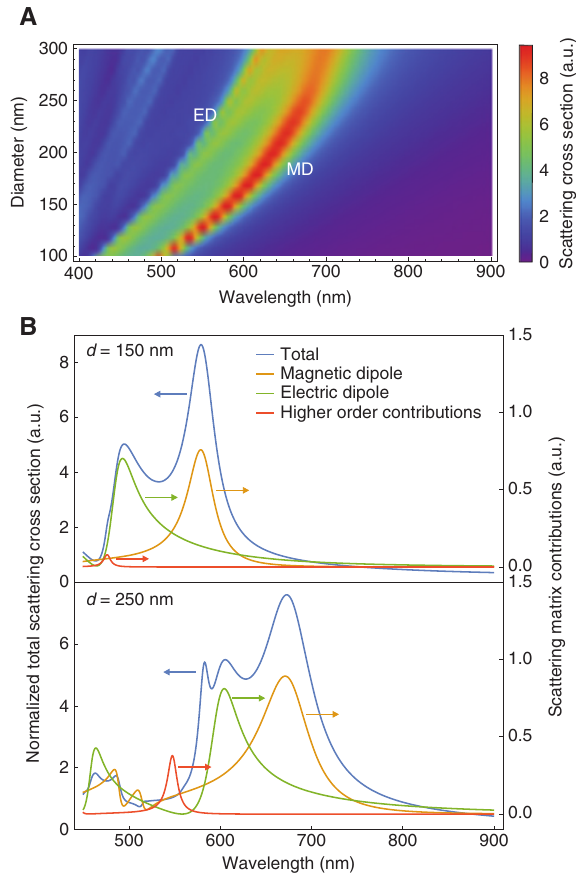
Figure 1: Calculated individual nanodisk scattering. (A) Calculated scattering spectra in color scale, for silicon nanodisks with 100 nm thickness and diameter ranging from 100 nm to 300 nm. The visible Mie resonances show a continuous redshift with increasing nanoparticle size, while higher-order contributions appear for larger particles. (B) Calculated resonance decomposition for small- (150 nm, top) and large-diameter (250 nm, bottom) nanodisks. The lowest energy resonance in both cases has a magnetic dipole character (orange line). The second peak, appearing at higher energy for larger particles, has instead an electric dipole character (green line), while multipolar contributions (red line) also appear at even shorter wavelengths. The arrows indicate to which y axis (left or right) corresponds each